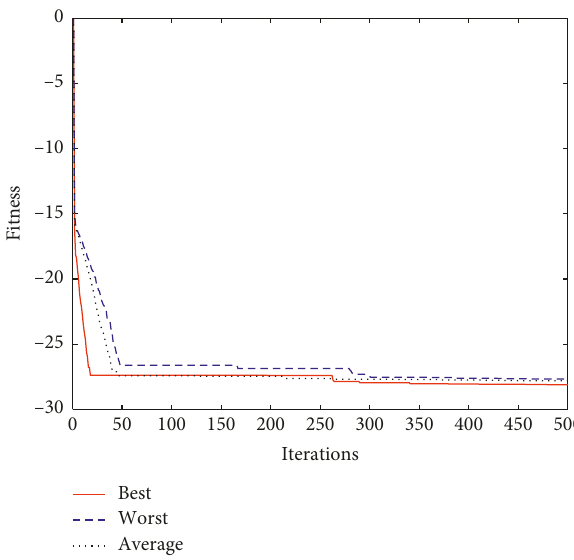
Figure 10: Convergence characteristics of GOA for 16-element linear array in example 4.